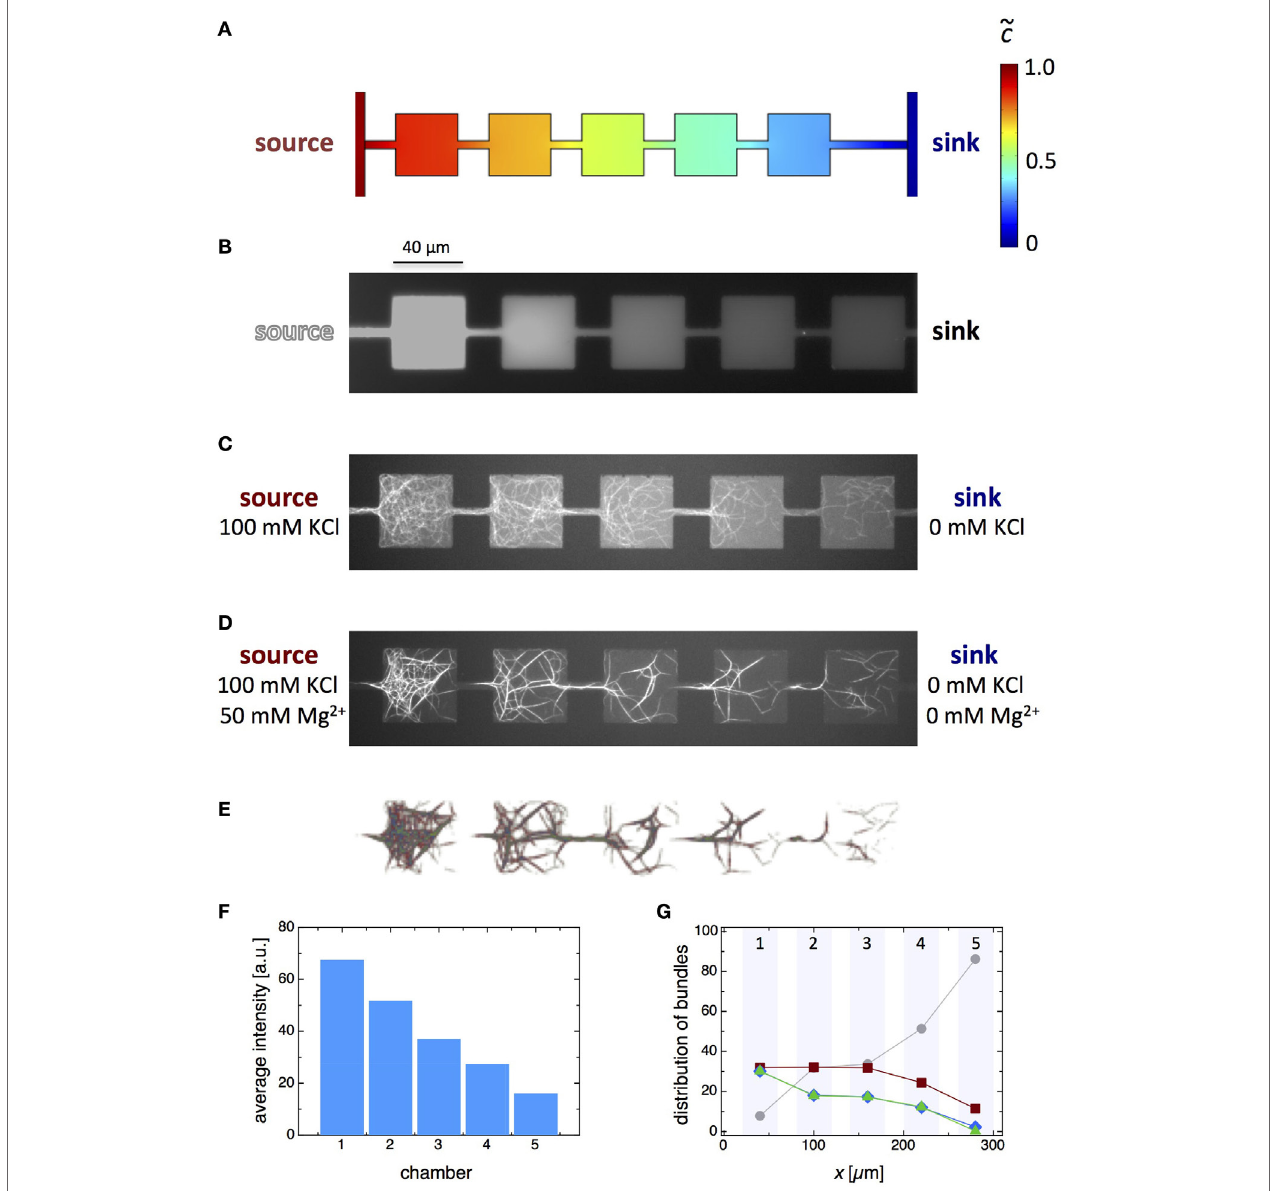
FigUre 6 | experimental realization of microfluidic gradient formation over consecutive microchambers . (a) Simulations reveal a step-like gradient profile with a steep gradient in the narrow connecting channels and an extremely weak gradient across individual squared microchambers. (B) The step-like gradient was experimentally verified by using an aqueous fluorescein solution as a source. (c) Actin polymerization in a KCl gradient over a series of five connected square microchambers shows a decreased amount of filaments from one microchamber to the next from the source to the sink. (D) Formation of bundled F-actin networks in a double gradient of KCl and Mg 2 + . (e) Fluorescence micrograph of the bundle network colorized according to the amount of filaments within the network links (gray represents bundles with n gray ~ 2–6, red with n red ~ 6–11, blue with n blue ~ 11–16, and green with n green ≳ 16). (F) Averaged fluorescence intensity plotted against the chamber number, where chamber 1 is closest to the source and chamber 5 is closest to the sink. The average fluorescence intensity is proportional to the overall number of filaments in a microchamber. (g) Distribution of four classes of bundle thickness, i.e., number of filaments, in the network links versus the microchamber